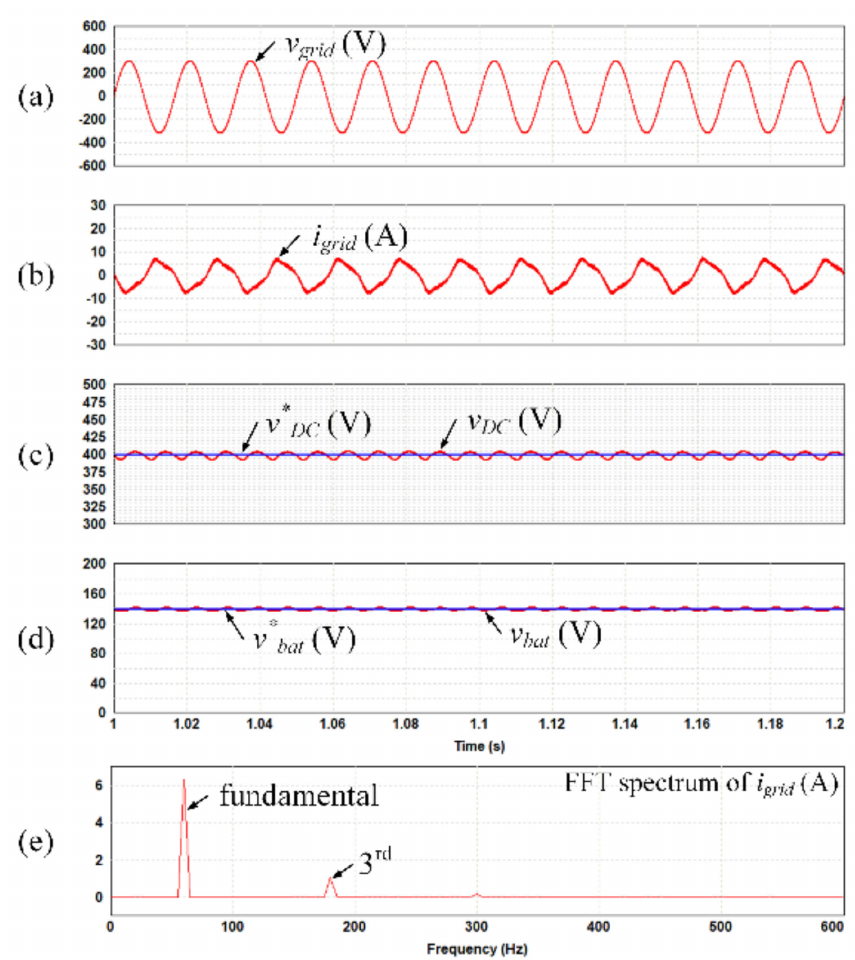
Figure 8. Simulation results of the integrated OBC operated in battery charging mode: ( a ) voltage and ( b ) current of the single-phase grid source, ( c ) DC-link voltage and reference DC-link voltage, ( d ) voltage of the battery and reference voltage of the battery, and ( e ) FFT spectrum of current of the single-phase grid